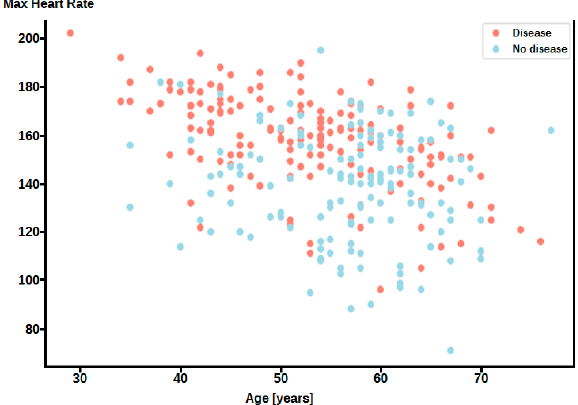
Figure 5. Age, blood pressure, and risk of MI.